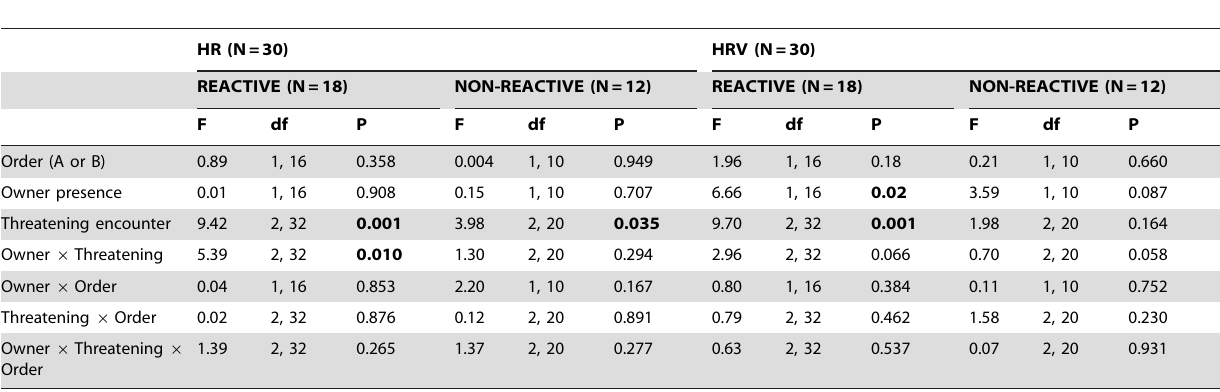
Table 2. Results regarding the change of the cardiac responses of dogs depending on their behavioural reactivity during separation (repeated measures ANOVA).